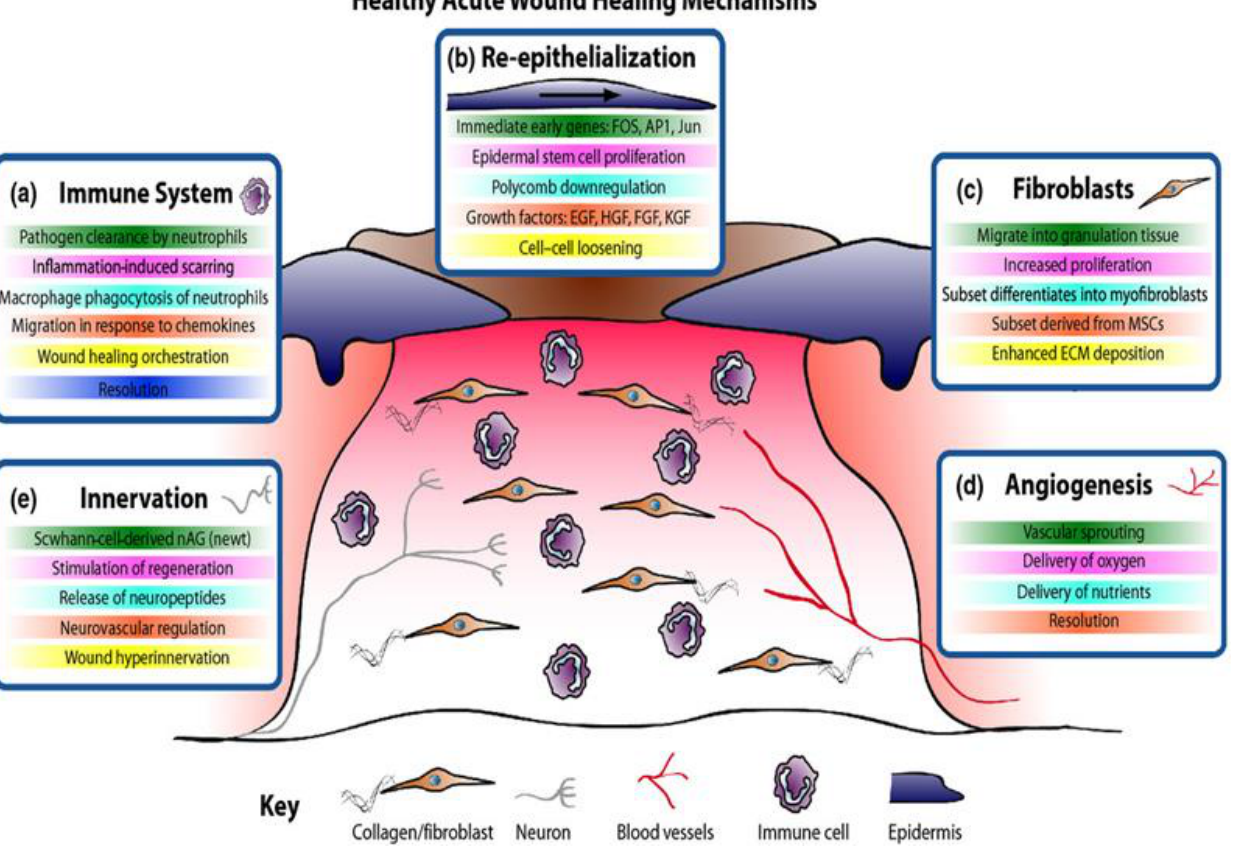
Figure 1. Wound healing process of healthy acute wounds as shown by Martin and Nunan [2]. Healthy AWs adhere to well-modulated cellular and molecular events, resulting in the rapid clearance of invasive microbes and subsequent removal of apoptotic neutrophils, with regulated cell migration promoting early wound contraction and tissue remodelling [2].